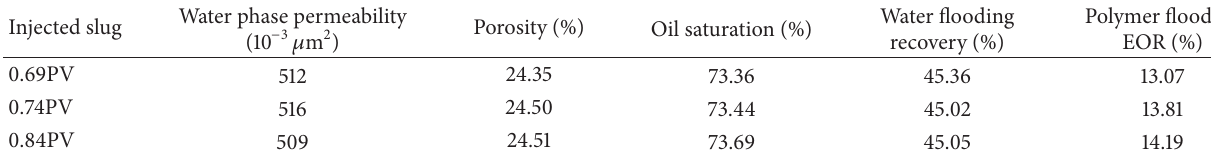
Table 1: Result of basic polymer flooding experiment.